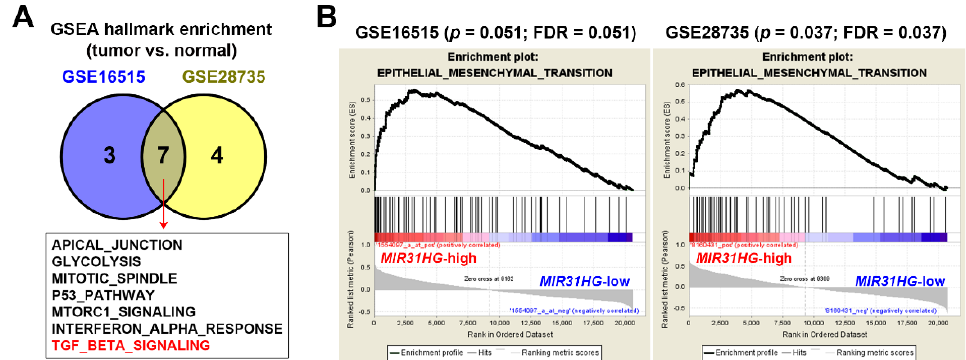
Figure 2. Gene set enrichment analysis (GSEA) revealed the potential role of MIR31HG in transforming growth factor β (TGF β ) signaling and the epithelial-to-mesenchymal transition (EMT): ( A ) A GSEA was performed to enrich 50 cancer hallmarks in pancreatic tumor tissues; ( B ) A GSEA was performed to enrich the EMT gene signature in two pancreatic cancer cohorts (GSE16515 and GSE28735). FDR, false-discovery rate.